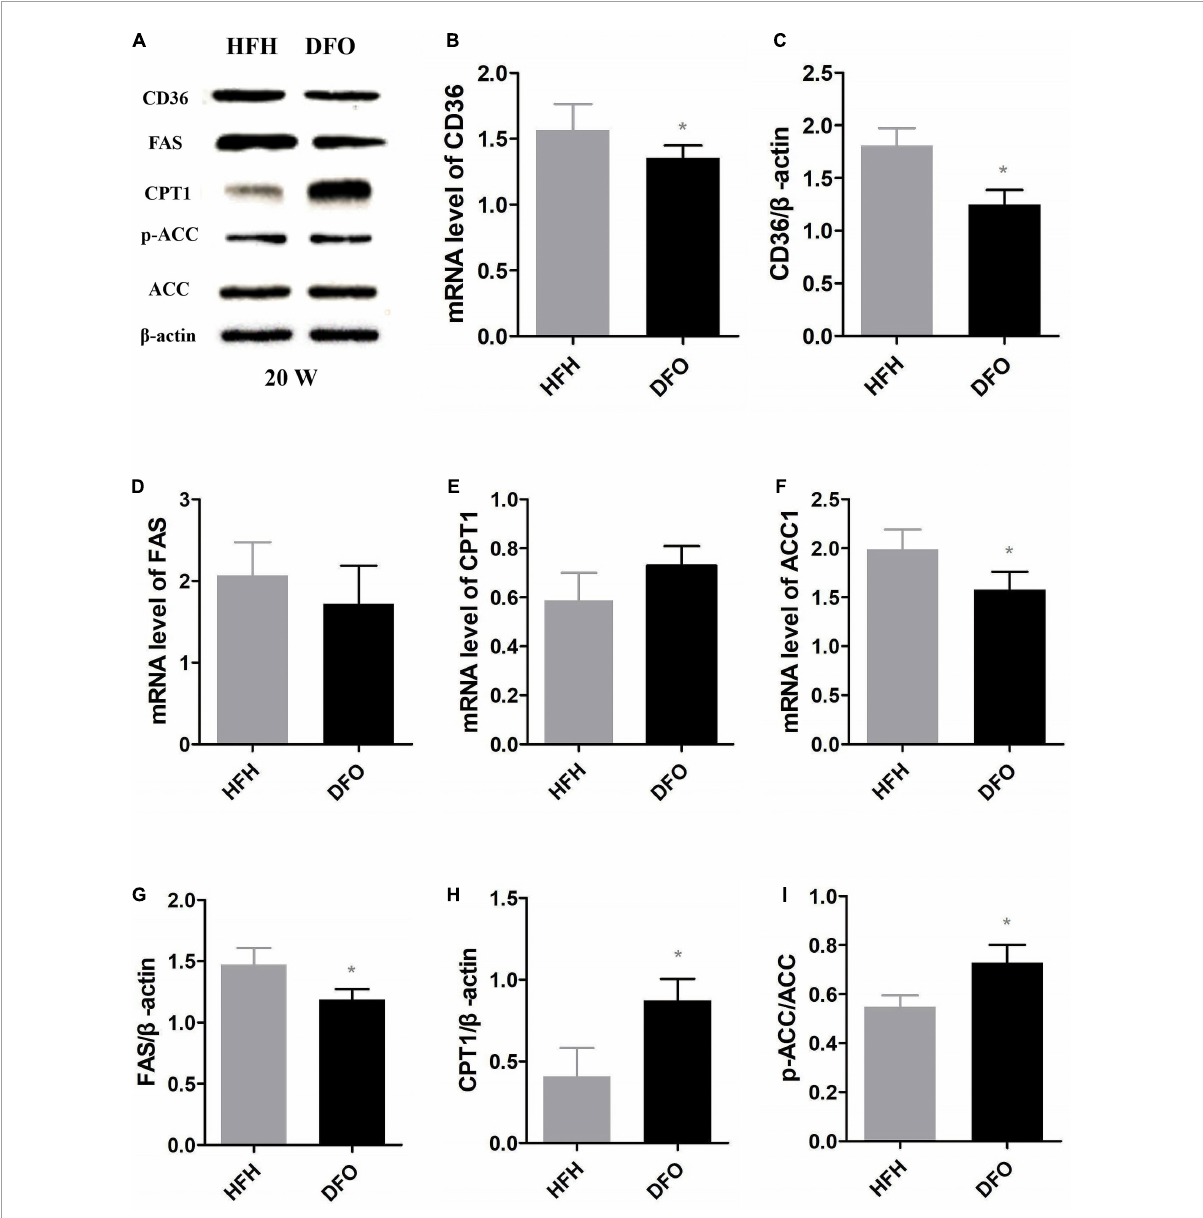
FIGURE6 DFO attenuated the effect of a high-fat, high-iron diet on lipid metabolism. (A–I) CD36, FAS, CPT1 and ACC mRNA and protein expression levels in the liver after DFO treatment. * Compared with HFH group, P <